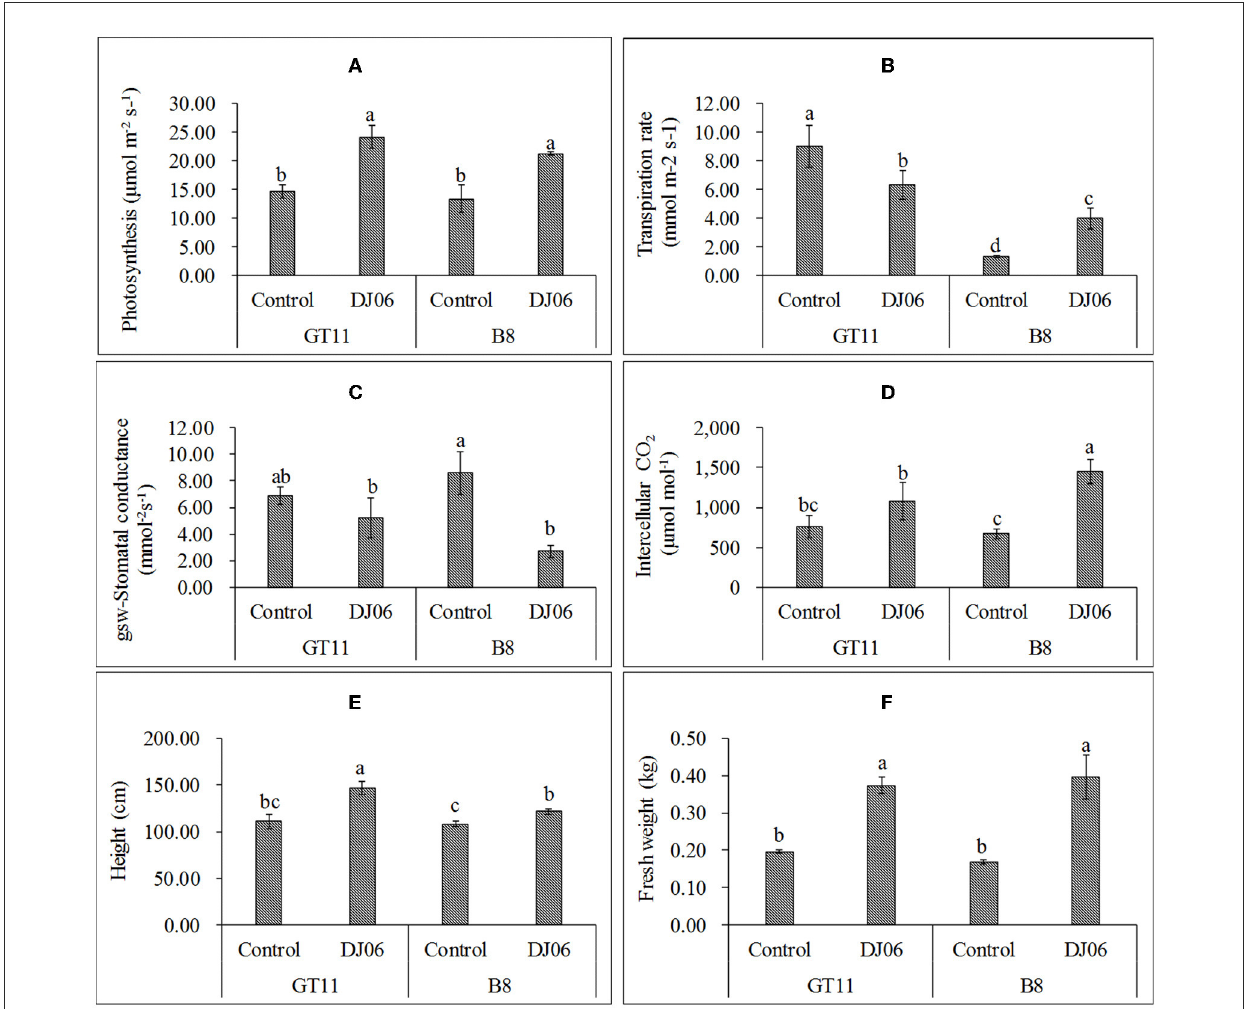
FIGURE5 The agronomic growth parameters in sugarcane varieties GT11 and B8 60 days after inoculation with Pseudomonas aeruginosa DJ06 compared with the control. (A) Photosynthesis; (B) transpiration rate; (C) stomatal conductance; (D) intercellular CO 2 ; (E) height; and (F) fresh weight. The same letter indicated that no significant difference was detected at Duncan’s multiple range test, P ≤ 0.05 ( n =